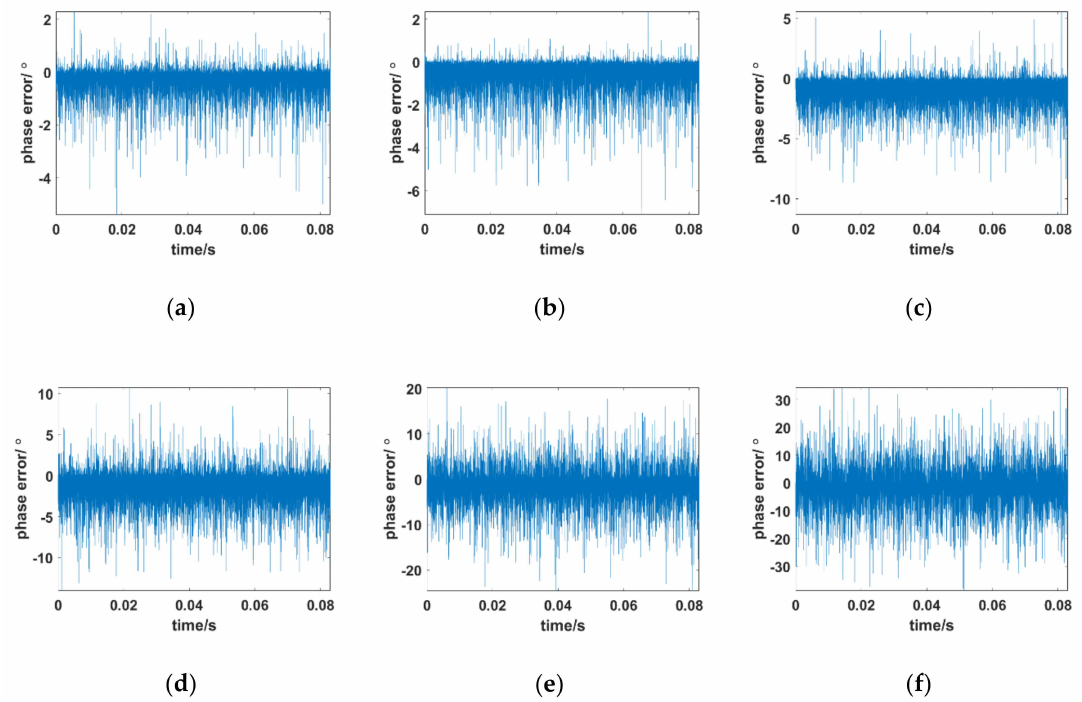
Figure 8. Phase error between the received signal and local carrier of the designed Kalman tracking loop at different signal-to-noise ratios (SNRs). ( a ) 10 dB; ( b ) 5 dB; ( c ) 0 dB; ( d ) − 5 dB; ( e ) − 10 dB; ( f ) − 15